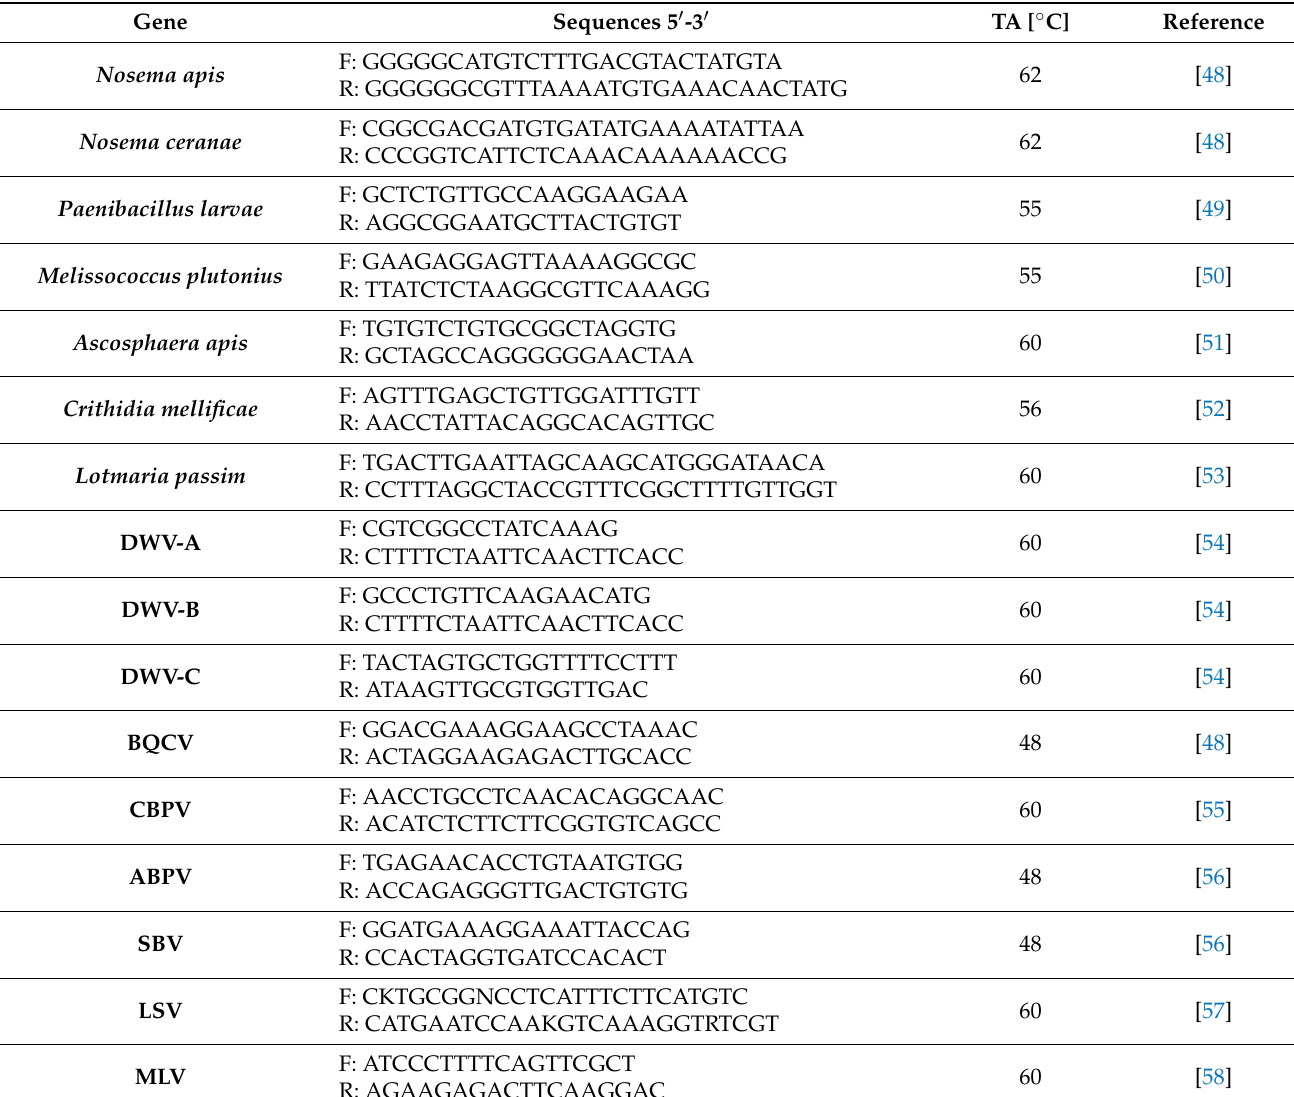
Table 1. Primers for PCR